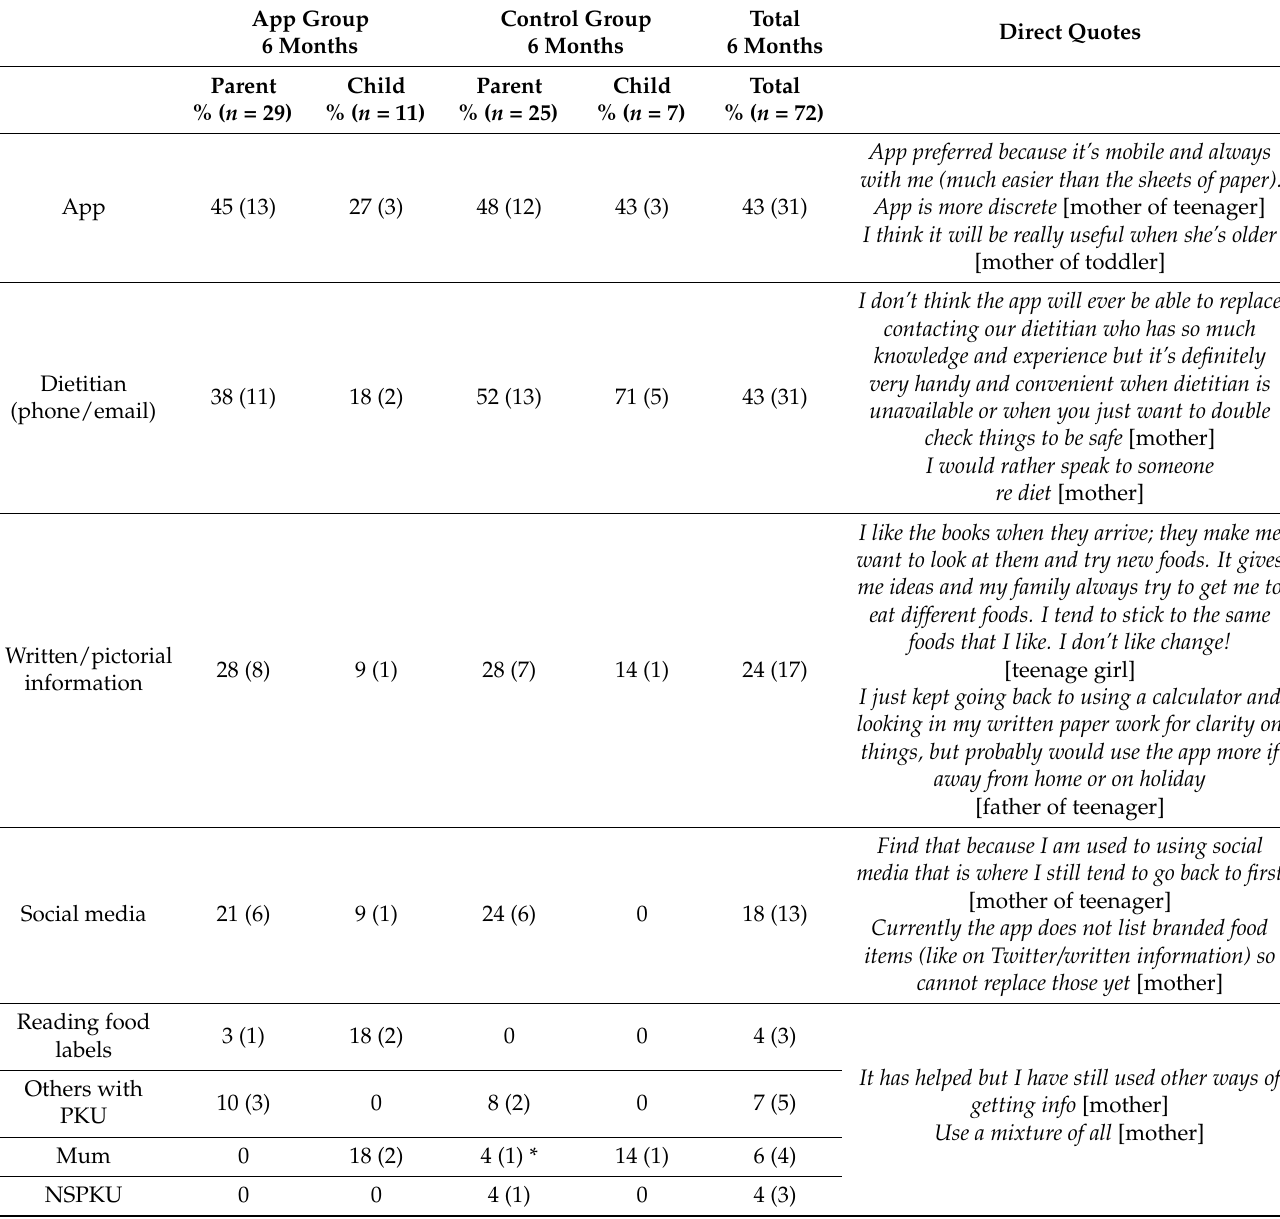
Table 10. Preferred method of obtaining diet